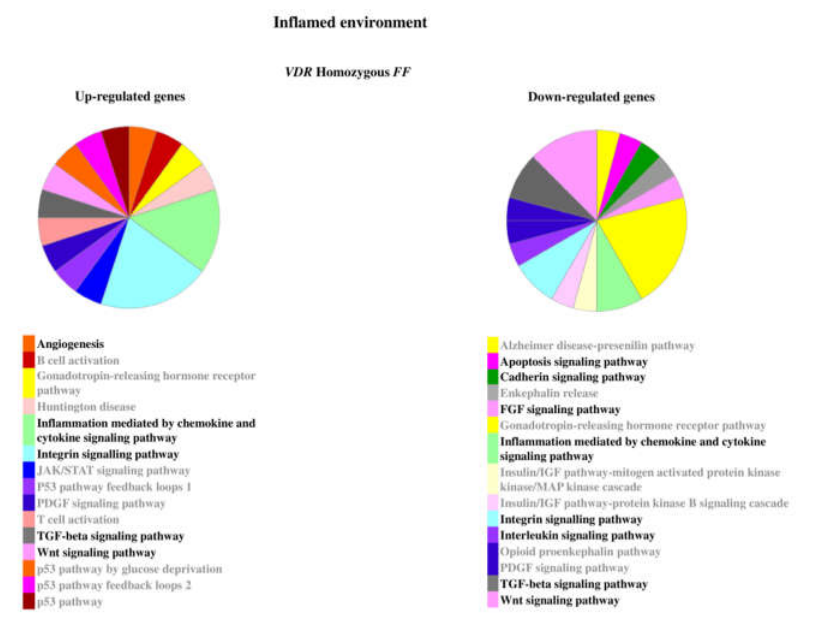
Figure 5. Pathways associated to the genes modulated by inflammatory stimulus in homozygous FF disc cells. Relevant pathways are highlighted in black bold. Pie chart obtained by